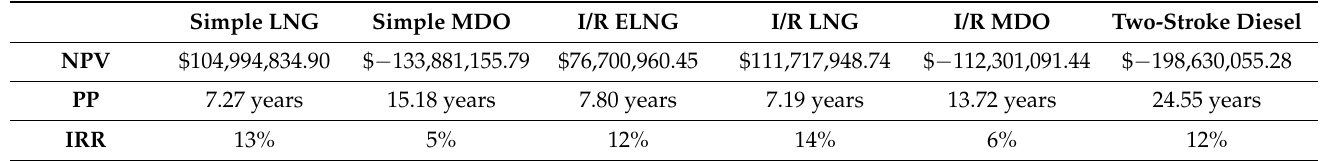
Table 5. Economic results for Route